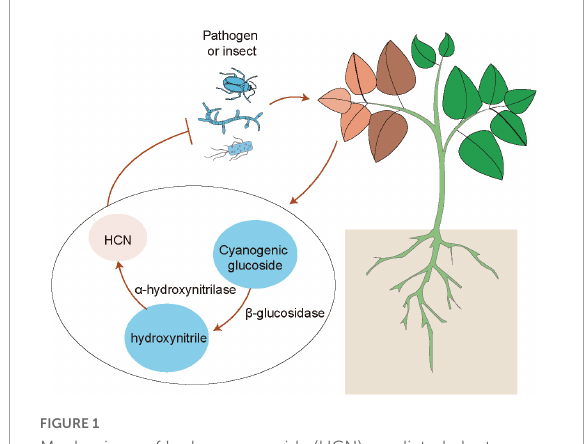
FIGURE1 Mechanisms of hydrogen cyanide (HCN)-mediated plant defense. When plants are subjected to the attacks of herbivores and pathogens, the accumulation of cyanogenic glucosides in leaves is quickly catalyzed by two key enzymes including β -glucosidases and α -hydroxynitrilase into producing toxic HCN, which confers the enhanced plant defense against herbivores and